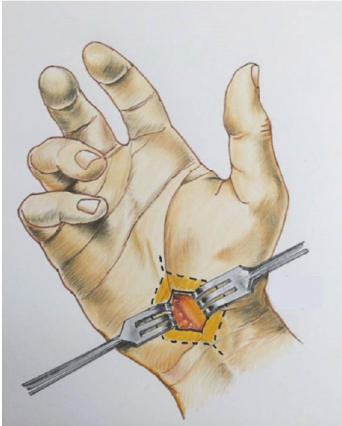
Figure 1: Artistic draw to show the key hole principle applied to the carpal tunnel microsurgical